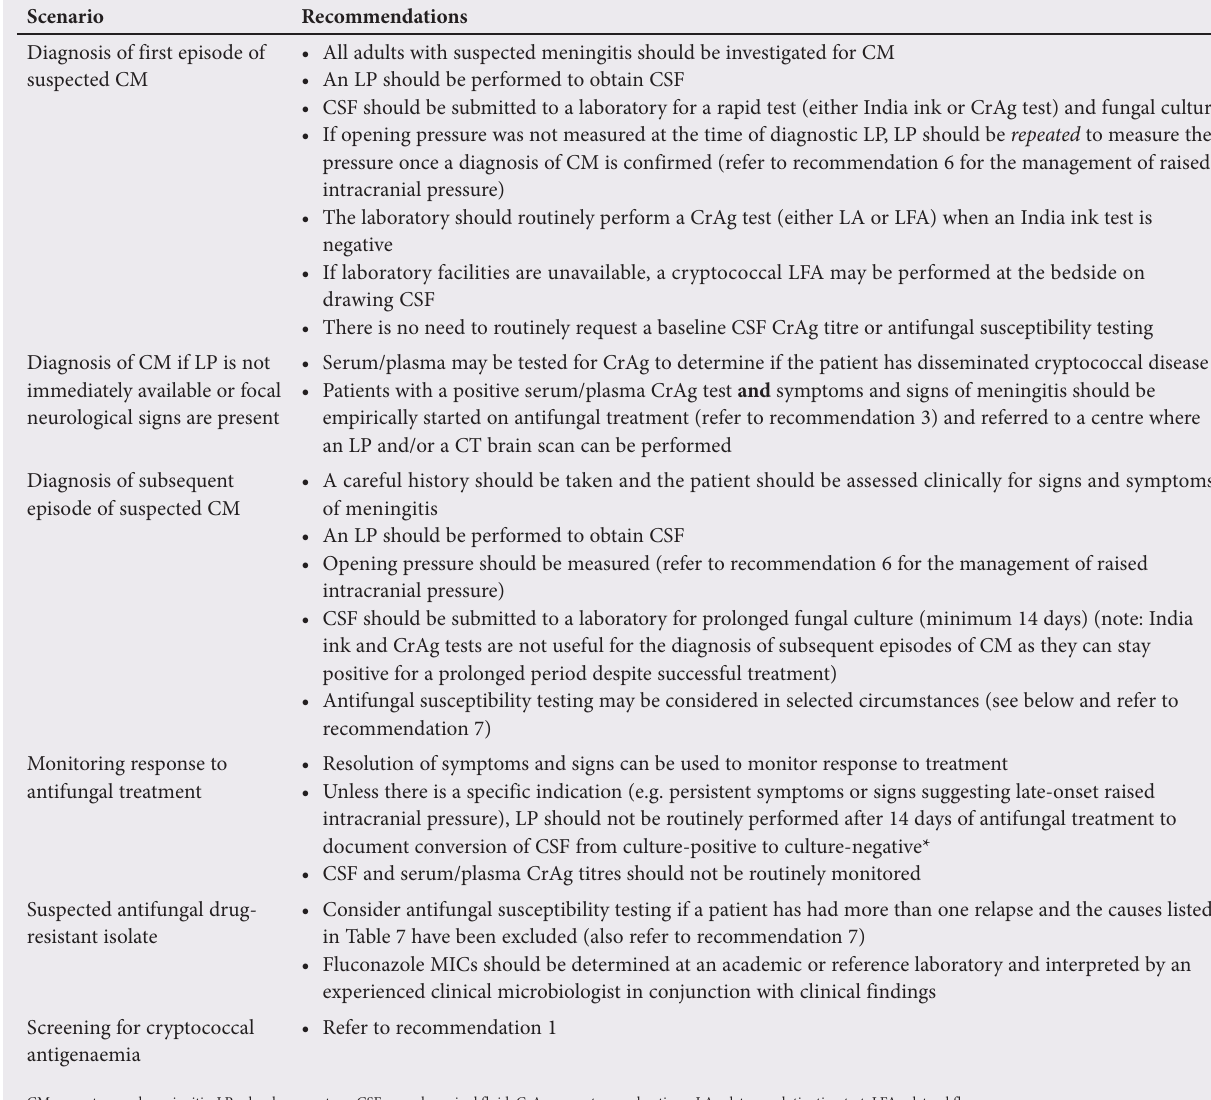
Table 2. Summary of recommendation 2: Laboratory diagnosis and monitoring